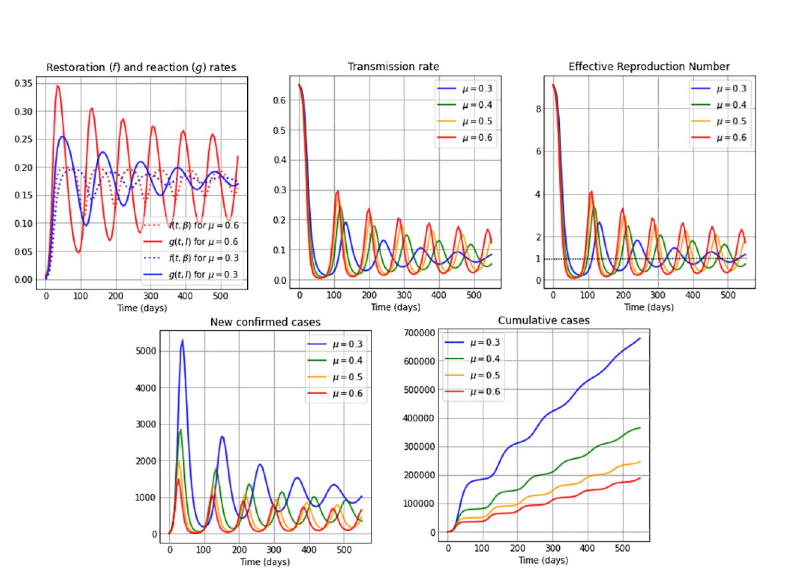
Fig 3. Simulations for a low restoration coefficient ν = 0.2. The first subplot illustrates the restoration rate f ( t , β ) (dotted) and the reaction rate g ( t , I ) (solid). The remaining subplots show: The transmission rate β ( t ), the effective reproduction number R ð t Þ , the new confirmed cases eE ( t ), and the cumulative cases E ( t ) + I ( t ) + R ( t ). The reaction e coefficient in each subplot are chosen to be μ : 0.3 (blue); 0.4 (green); 0.5 (orange) and 0.6 (red), and the remaining parameter values and initial conditions are as in Table